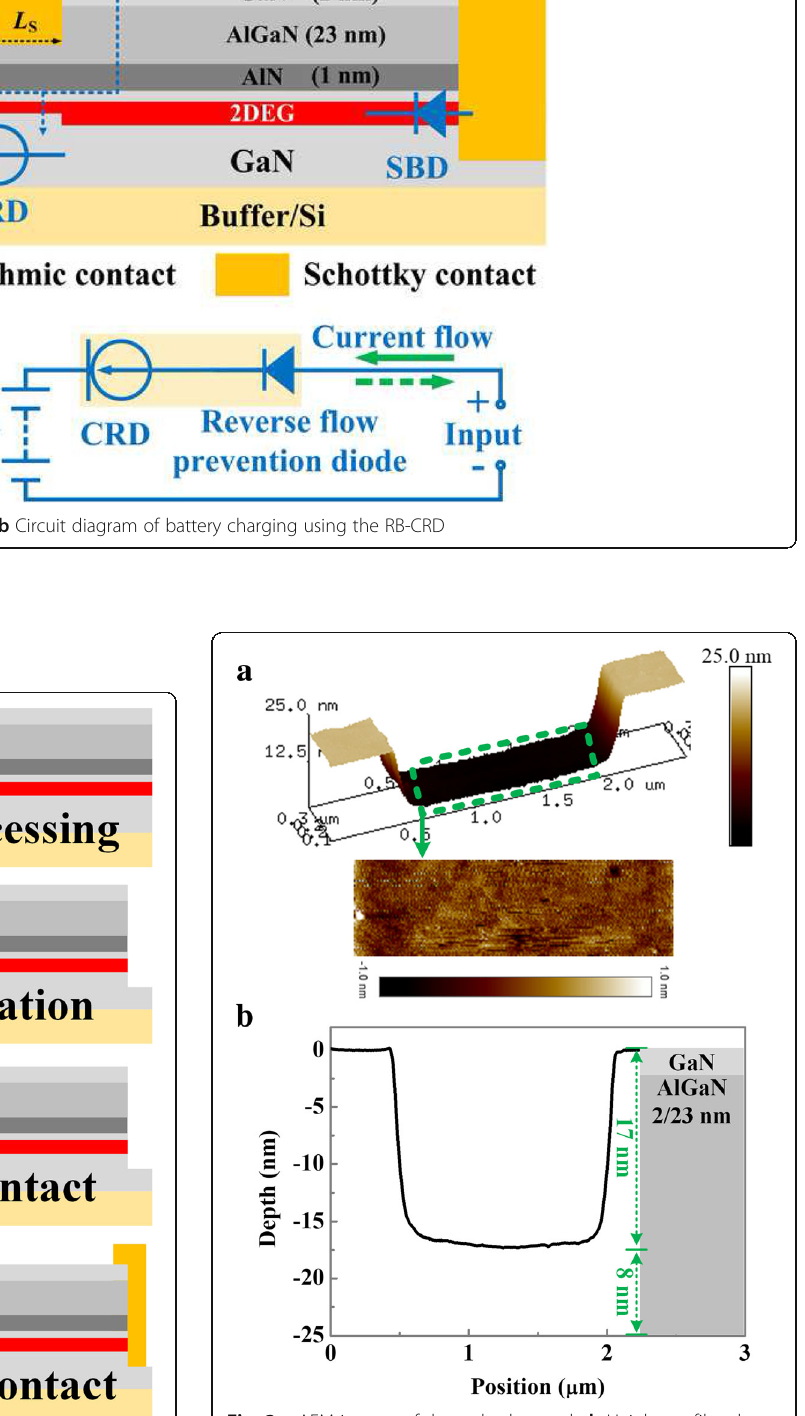
Fig. 3 a AFM images of the cathode trench. b Height profile taken from the cathode